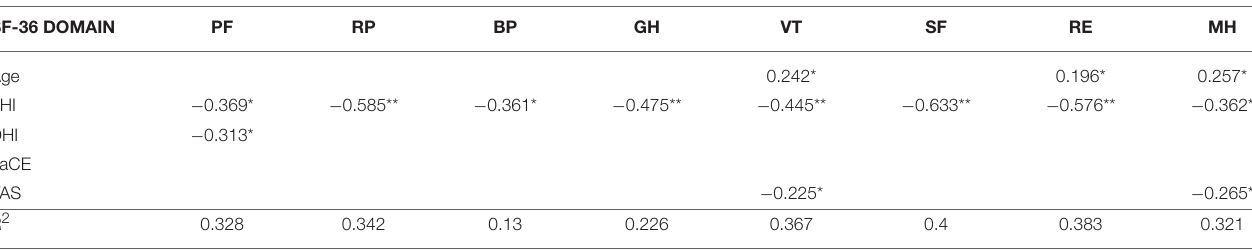
TABLE 3 | Multiple regression analysis of QoL and the variables age and severity of subjective symptoms.